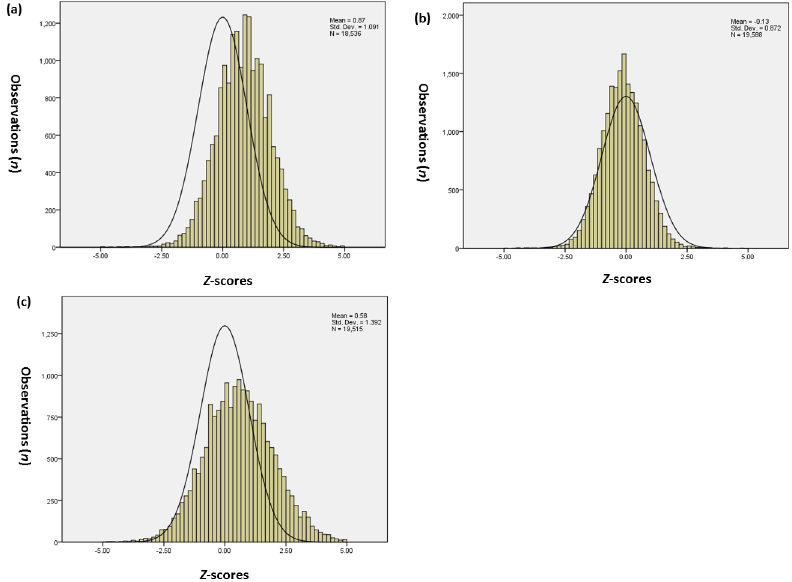
Fig 1. Z-scores distributions of FL calculated from each reference chart superimposed on the non- skewed standard normal curve. Z-score distributions of FL measurements calculated using each of the reference equations of Leung TN, et al (a), Chitty LS, et al (b), Papageorghiou, AT, et al (c), in comparison with the expected standard normal